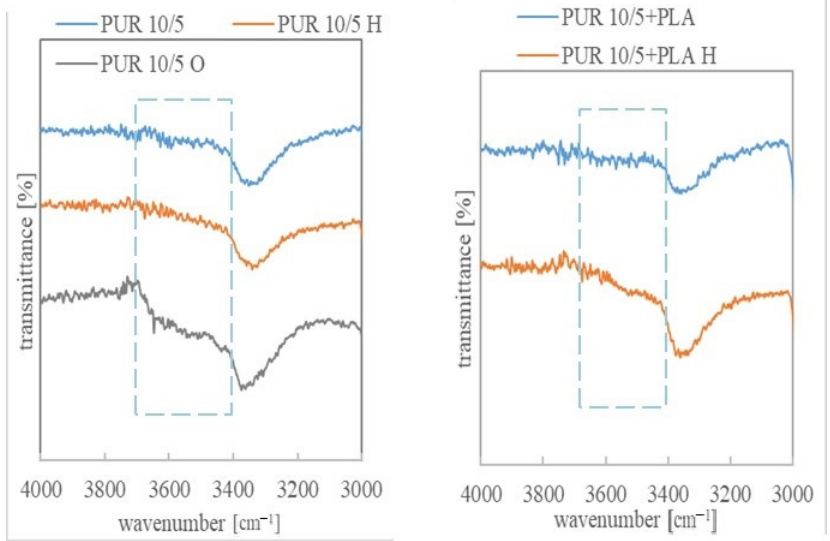
Figure 3. ATR-FTIR spectra in the range 3000-4000 cm − 1 of PUR 10/5 and PUR 10/5+PLA, before and after degradation in hydrolytic (36 weeks) and oxidizing (7 weeks) solutions.